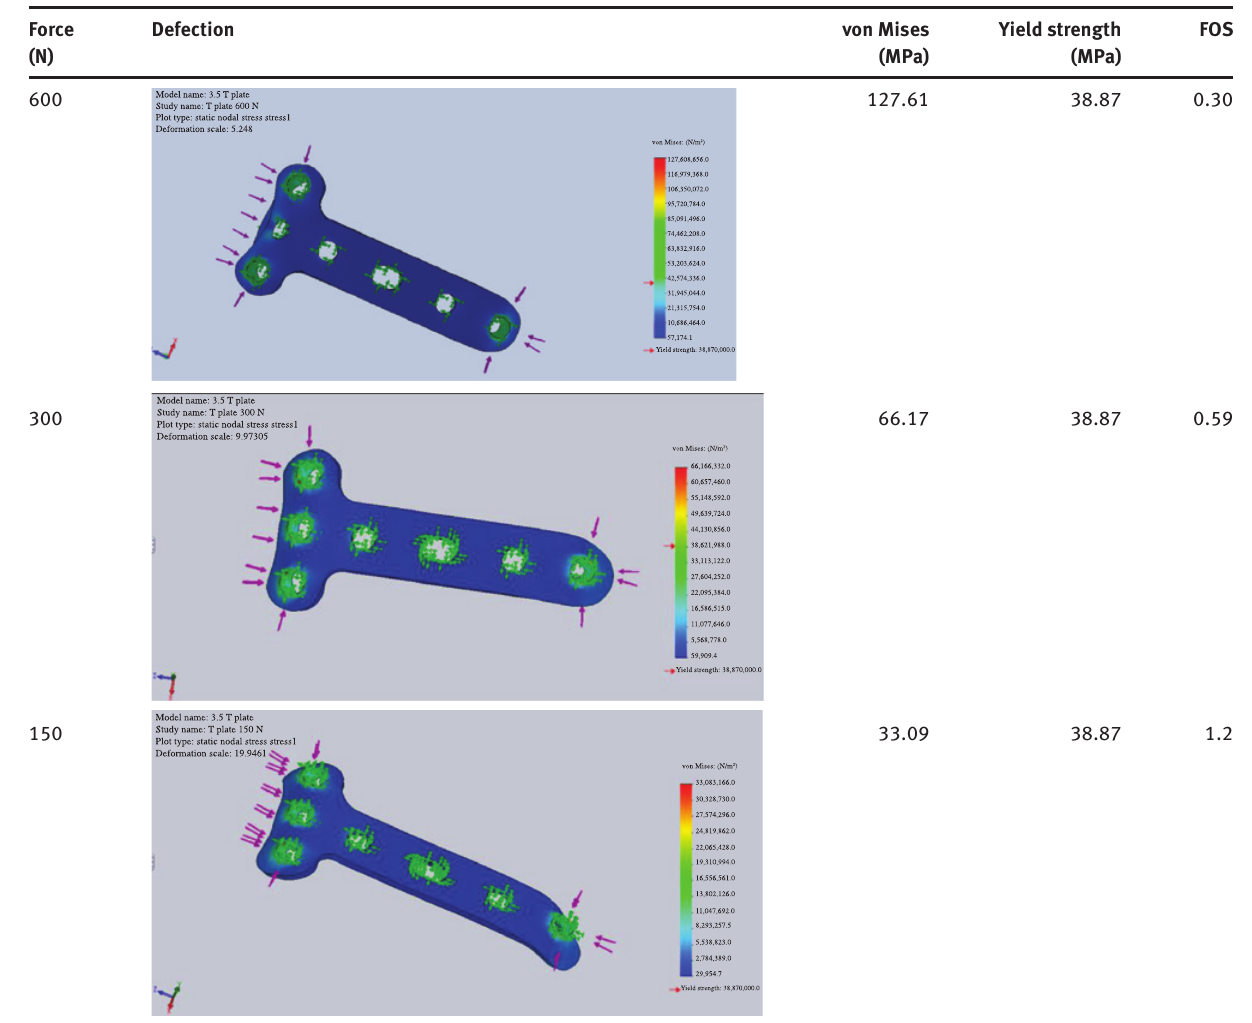
Table 15: Tensile force of bone fixation